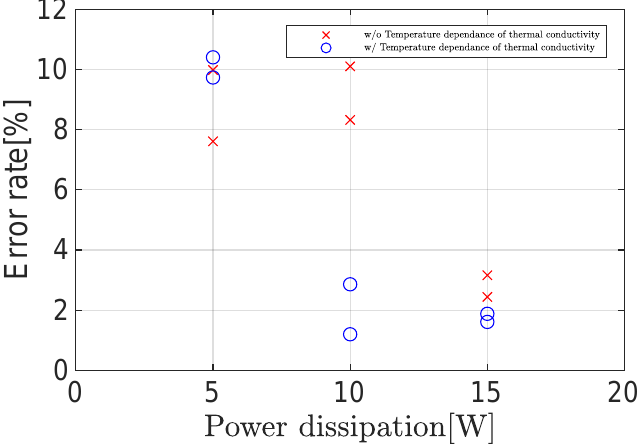
Figure 16. Error rate (w/o operator theory).